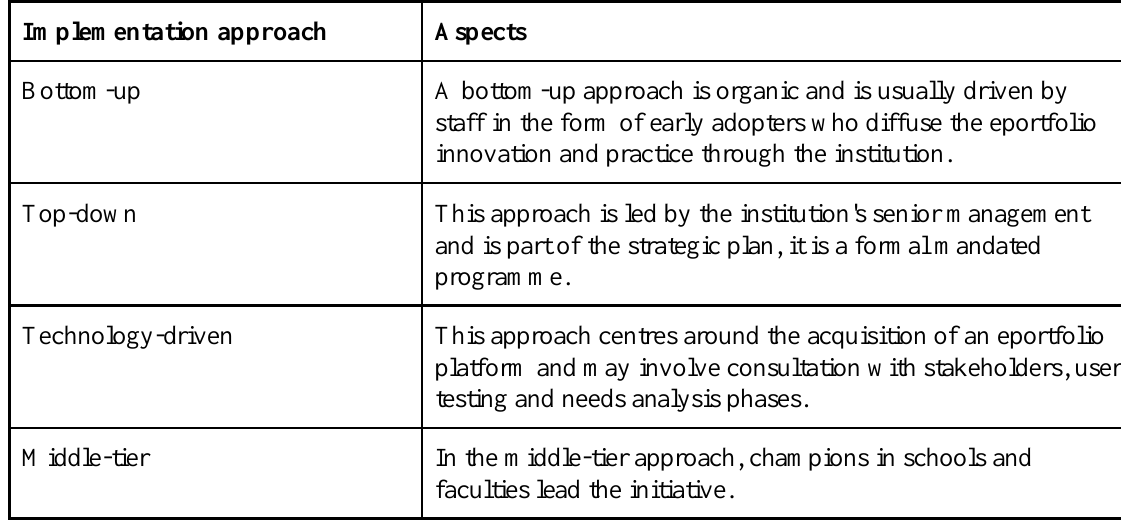
Table 1. Eportfolio implementation approaches, adapted from Stevens